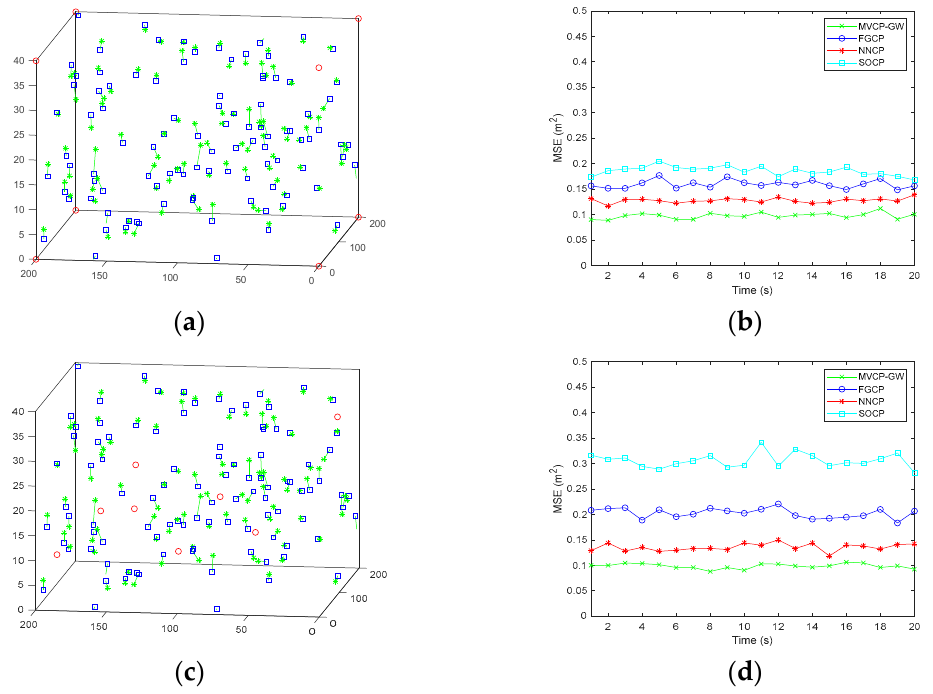
Figure 4. Simulation results of positioning error MSE under different distribution of base stations: ( a ) schematic diagram of ideal distribution topology of base stations; ( b ) the relation diagram of positioning error MSE with time under the ideal distribution of base stations; ( c ) schematic diagram of random distribution topology of base stations; ( d ) the relation diagram of positioning error MSE with time under the random distribution of base stations.